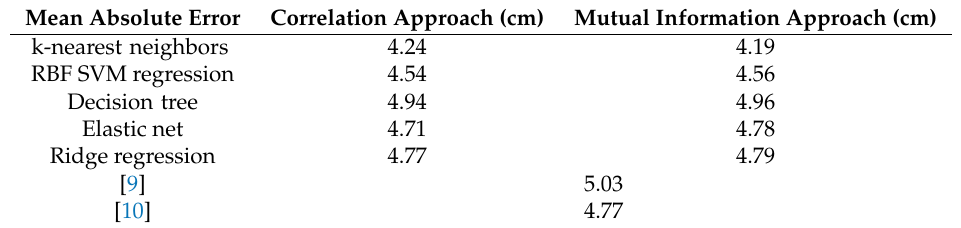
Table 4. Accuracy comparison of different machine learning algorithms and approaches with two neural network step length